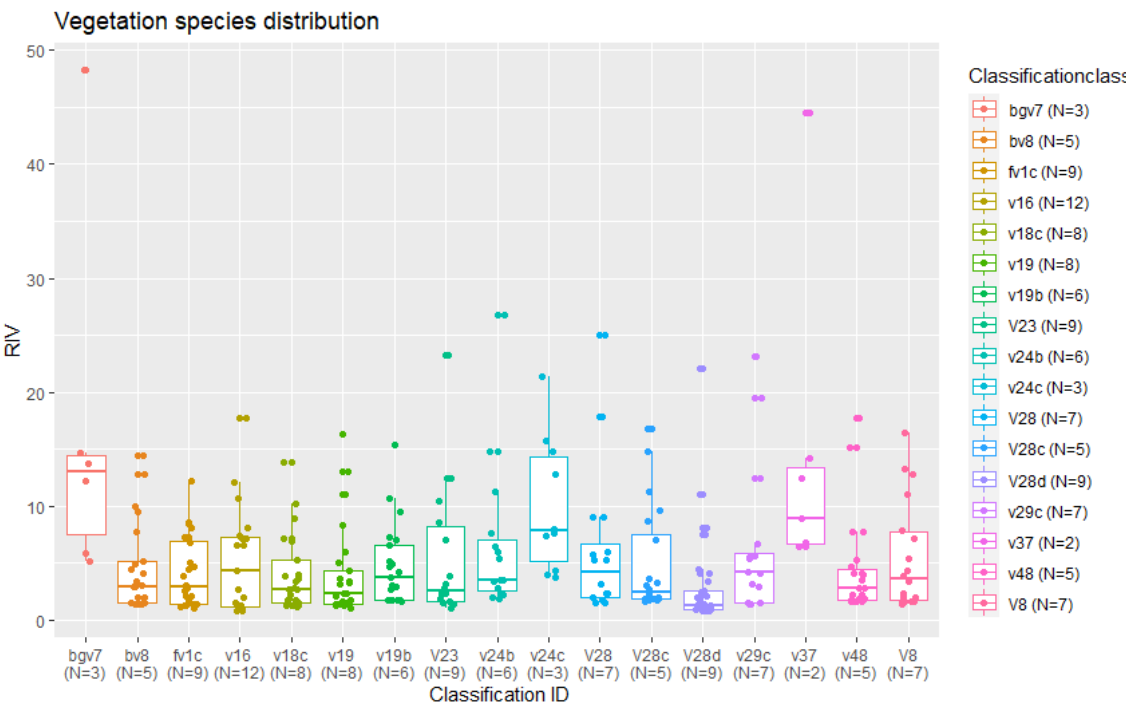
Figure 7. Distribution of vegetation species’ dominance values per classification class, where ‘N’ represents the number of ground truthing sampling plots. Most of the classification classes had majority of the contributing species occurring within the interquartile range and the dominant species occurring within the upper extreme range. However, two classes Bgv7 and Veg37 show the dominant species occurring as very extreme outliers, and consistently had much fewer ground truthing sampling plots N = 3 and N = 2 respectively.